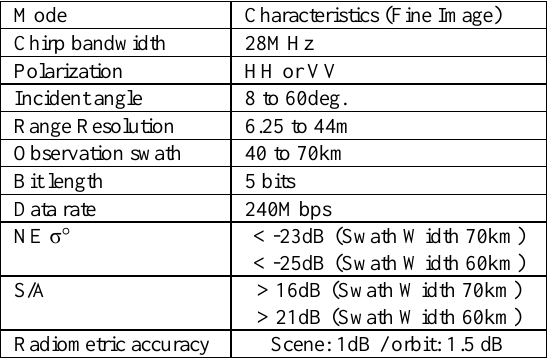
Table 3. The characteristic of ALOS/PALSAR image (Rosenqvist, et. al, 2004)